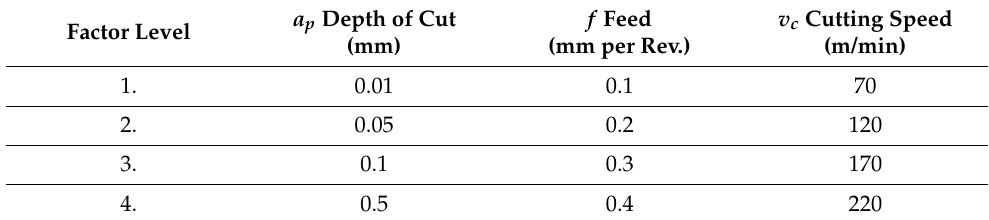
Table 3. Cutting process conditions for Taguchi L16 orthogonal array.